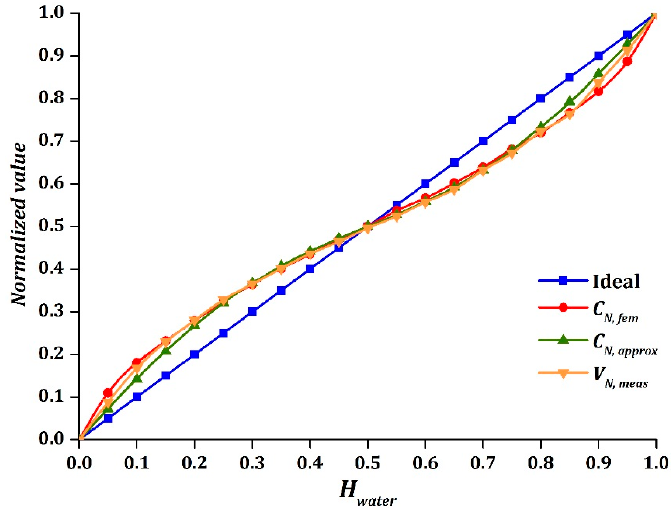
Figure 12. C N , fem , C N , approx , and V N , meas versus H water for air-water stratified flow. Table 9. Maximum absolute difference of (cid:3627)(cid:1829) (cid:3015),(cid:3033)(cid:3032)(cid:3040) − (cid:1829) (cid:3015),(cid:3028)(cid:3043)(cid:3043)(cid:3045)(cid:3042)(cid:3051) (cid:3627) and (cid:3627)(cid:1848) (cid:3015),(cid:3040)(cid:3032)(cid:3028)(cid:3046) − (cid:1829) (cid:3015),(cid:3028)(cid:3043)(cid:3043)(cid:3045)(cid:3042)(cid:3051) (cid:3627) for air-water stratified flow.